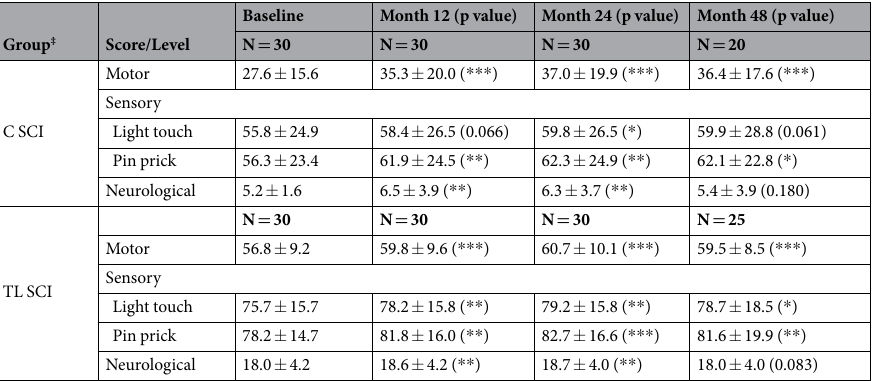
Table 3. Motor score, sensory score, and neurological level in each group † . † Compared with baseline, based on Wilcoxon signed rank test. Values are presented as means ± SDs. ‡ C SCI = cervical spinal cord injury; TL SCI = thoracolumbar spinal cord injury. * Significant at p < 0.05. ** Significant at p < 0.005. *** Significant at p < 0.0001.